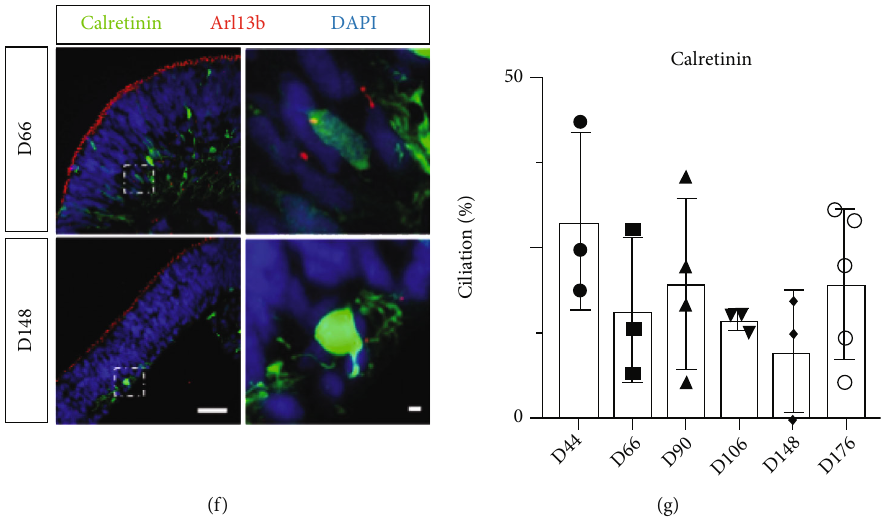
Figure 4: AP2 α -positive amacrine cells stably express primary cilia in hESC-derived retinal organoids. (a) Confocal images of retinal organoid sections (from day 44 to day 176) costained with AP2 α (in green) and Arl13b (in red). (b, c) Quanti fi cation of ciliation and ciliary length of AP2 α -positive amacrine cells during retinal organoid development. (d) Representative images of retinal organoid sections costained with GAD67 (green), AP2 α (in gray, not shown), and Arl13b (red). (e) Representative confocal images of retinal organoids immunostained for calretinin (green), AP2 α (in gray, not shown), and Arl13b (red). (f, g) Quanti fi cation of ciliation of GAD67-positive (f) and calretinin-positive (g) amacrine cells. Nuclei are visualized by staining with DAPI (blue). Scale bar: 10 μ m; magni fi ed, 1 μ